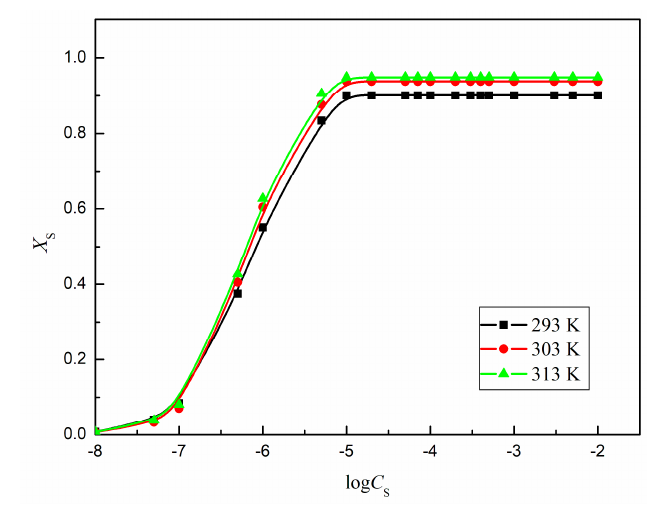
Figure 12. Mole fraction of the area occupied by TS-OE12 at the water-air interface ( X S ) vs. the logarithm of its concentration (log C S ) at 293 K, 303 K and 313 K, determined from Γ S / Γ ∞